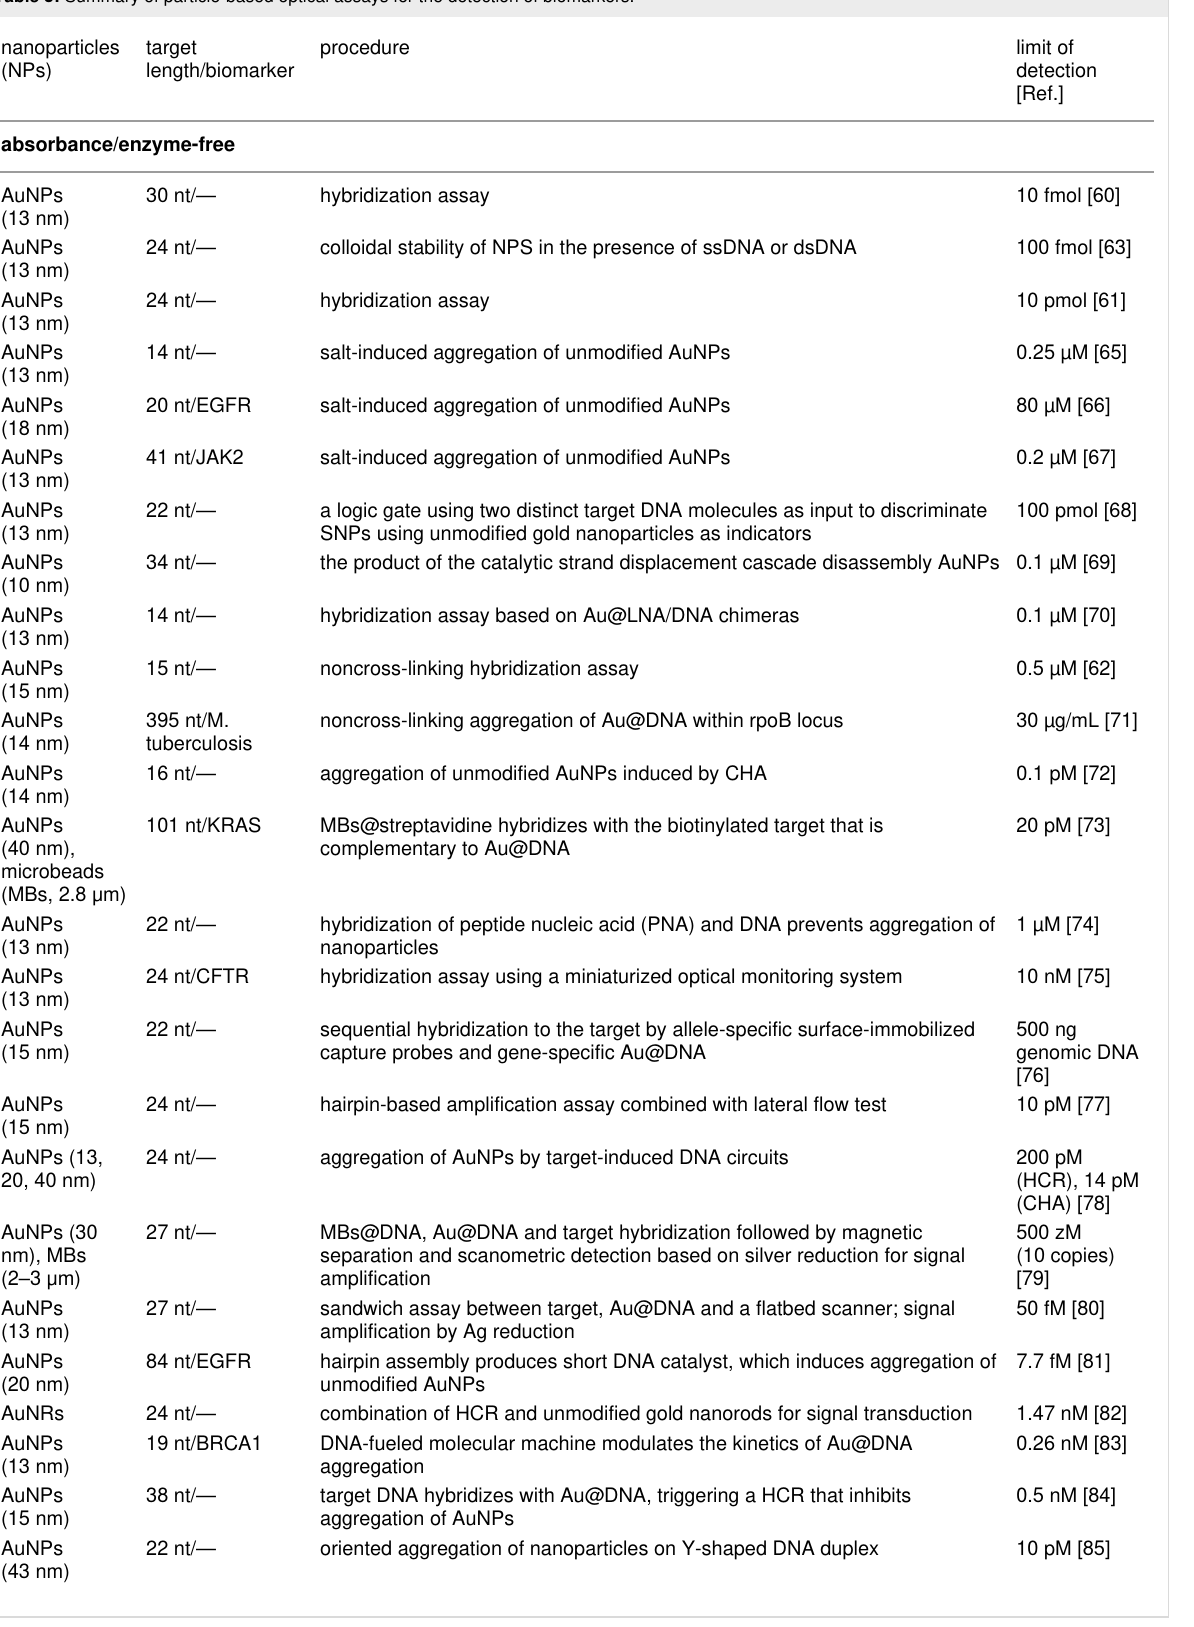
Table 3: Summary of particle-based optical assays for the detection of biomarkers. nanoparticles